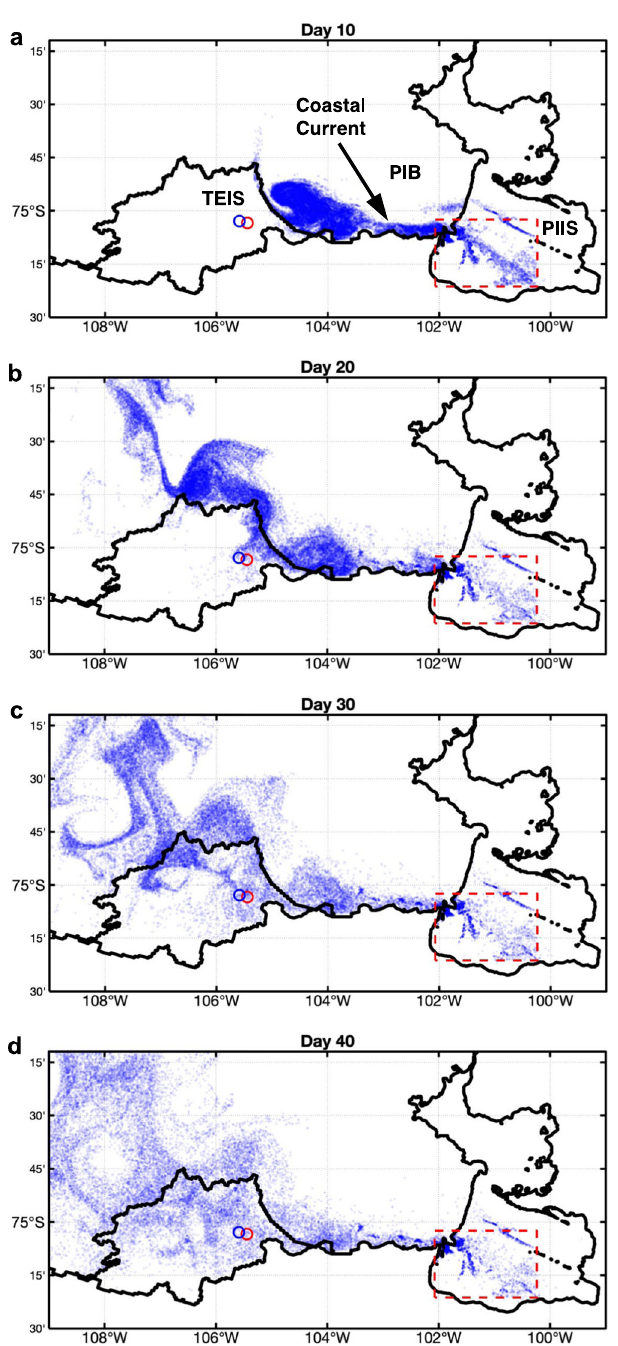
Fig. 5 | Trajectories of simulated particles released in the Pine Island Ice Shelf (PIIS) cavity (red rectangle). A total of 200645 particles were released beneath PIIS in the red rectangle in an of fl ine simulation. For illustration purposes, the particles were restricted to meltwater content of 10 – 25gkg − 1 and depths 250 – 400m, based on day 2 of the simulation (when particles leave the cavity), which reduces the total number of particles to 42521. The snapshots show particle location for days a 10, b 20, c 30, and d 40 of the simulation. Open blue and red circles depict AMIGOS3a and AMIGOS3c sites, respectively. Thwaites Eastern Ice Shelf (TEIS) and Pine Island Bay (PIB) are